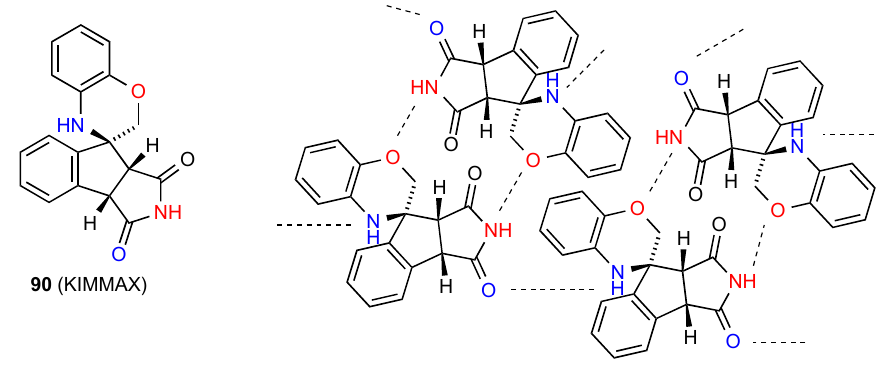
Figure 32. Structure adopted by compound 90.